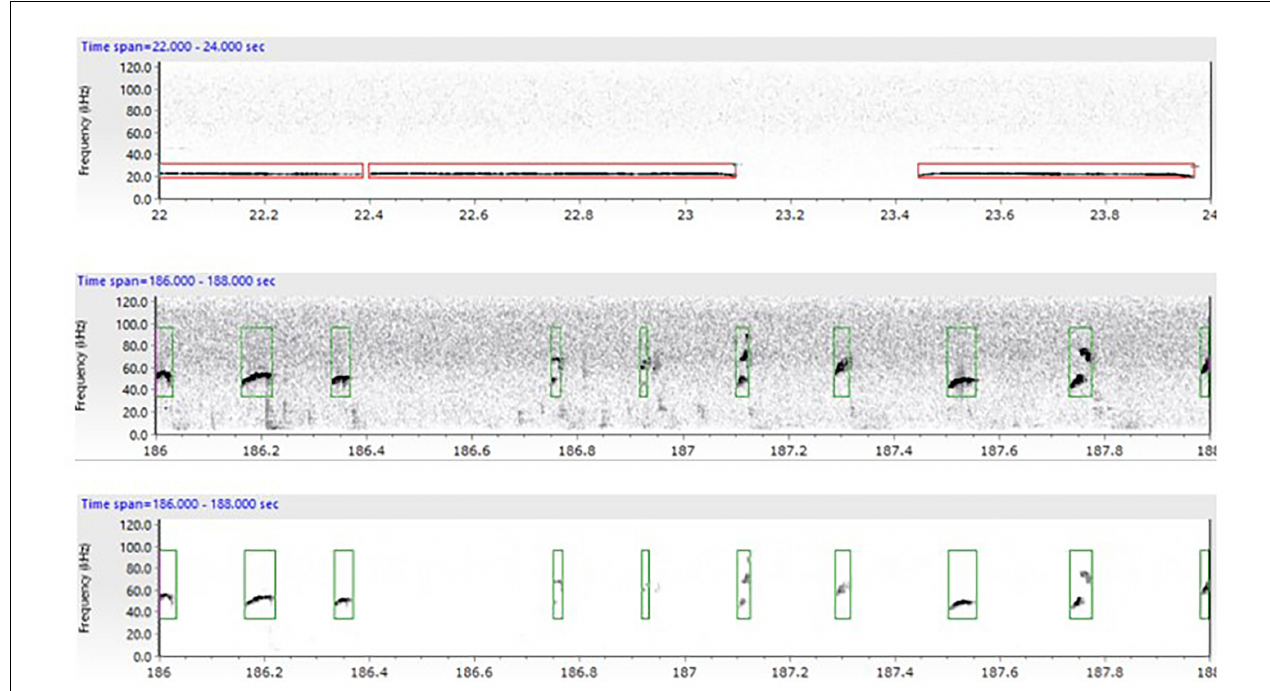
FIGURE 3 | Example spectrogram extracted from the UltraVox XT version 3.2.108 program depicting both 22 kHz (upper image) and 50 kHz calls (lower images). The spectrogram shows the calls emitted in a specific timeframe while being tested in the liberation task. Each spectrogram depicts the communication between the two animals. The red boxes indicate the automatic measurements of calls in the 18–32 kHz frequency range (alarm calls) while the green boxes indicate calls in the 32–96 kHz frequency range (appetitive calls). In the lower panel background noise has been